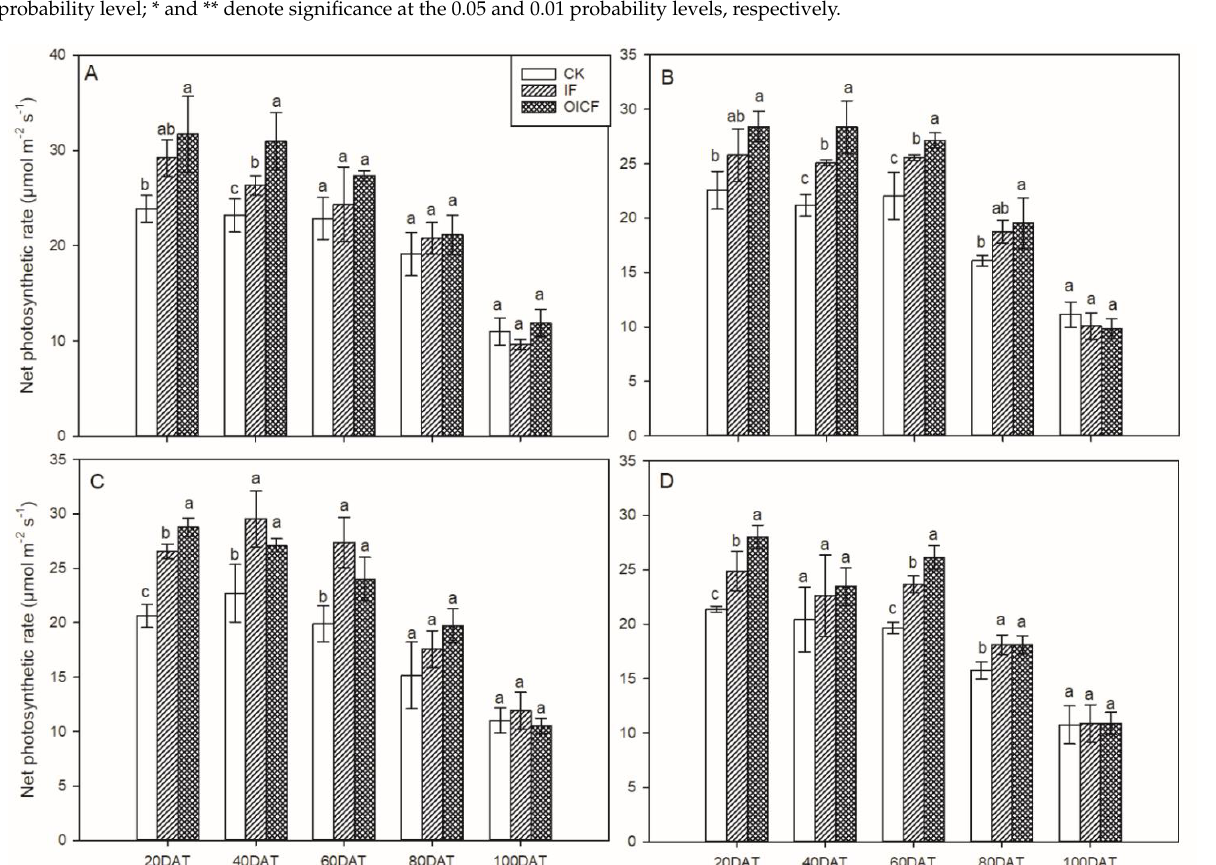
Seed setting rate is the ratio of the number of full filling grains to the total number of grains. Values sharing a common